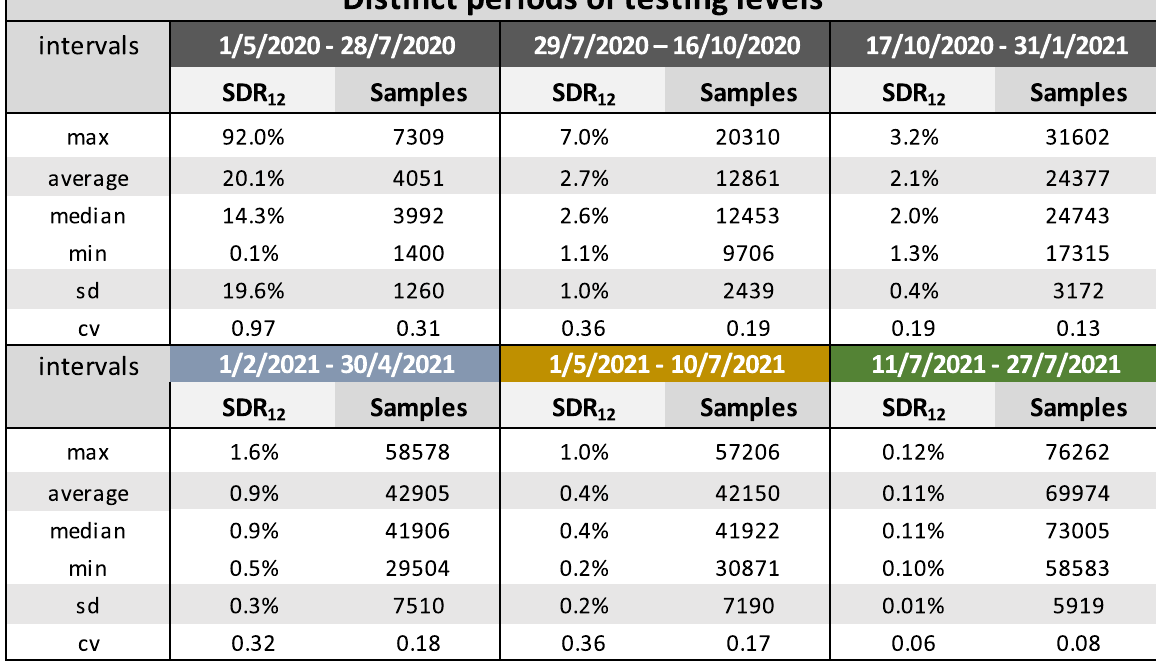
Table 1. Characterization of the Severity Detection Rate and the number of daily tests for each of the six time intervals of distinct testing levels in Greece.